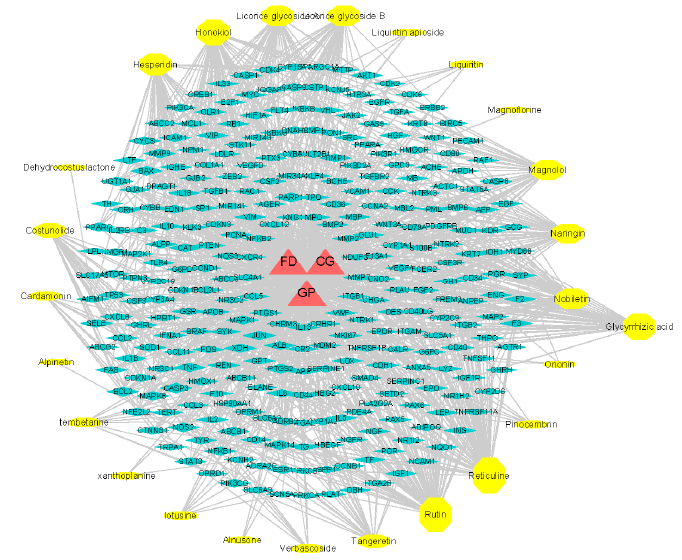
Figure 12. Network of three diseases GP, CG, FD (red) and 25 potential active ingredients (yellow) predicted to have 303 candidate targets (blue).